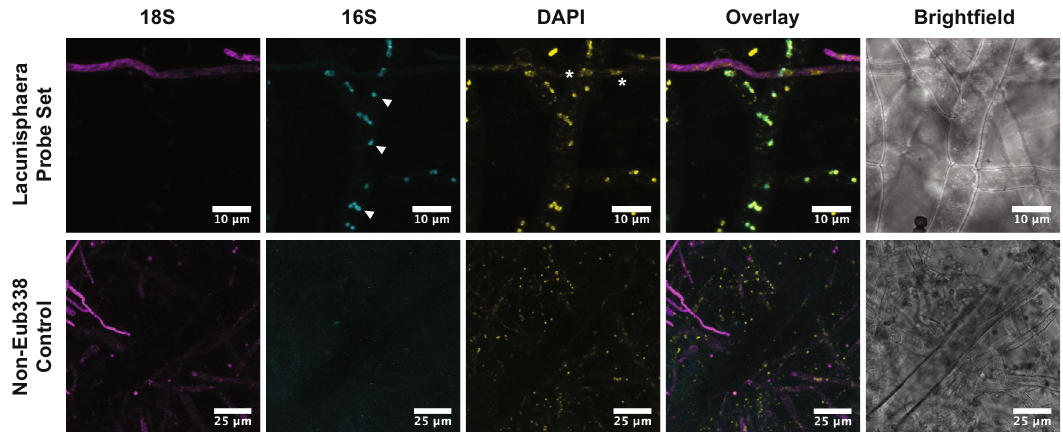
Fig. 5 Fluorescence in situ hybridization staining with Lacunisphaera speci fi c probes in an Aspergillus isolate. FISH staining was conducted on an Aspergillus isolate using a universal 18S rRNA probe (magenta) and a Lacunisphaera genus-speci fi c 16S rRNA probe set (cyan). Coccoid structures attributed to the bacterial associate are shown with arrowheads. Non-speci fi c DAPI DNA staining displays co-localization with 16S signals from the bacteria that appear distinct from the nuclear morphology of the fungus (asterisks). A non-hybridizing probe (Non-Eub338) was used as a